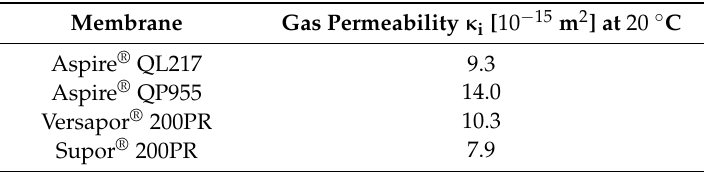
Table 4. Gas permeability values for single phase conditions.